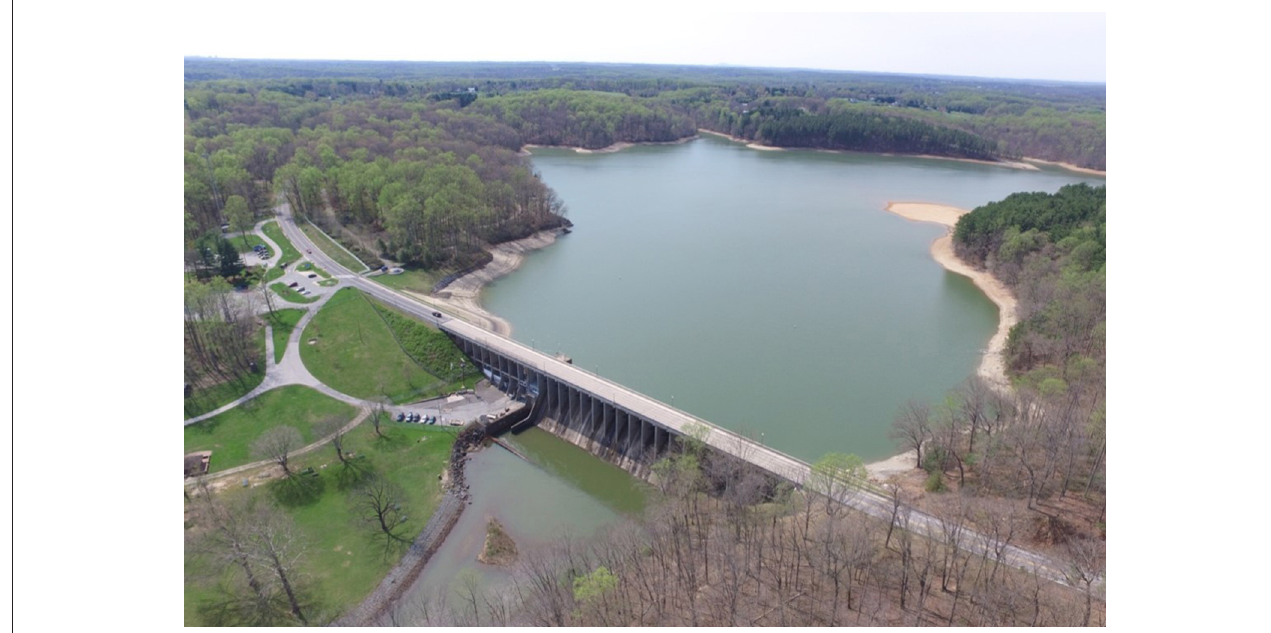
FIGURE 1 | The Brighton